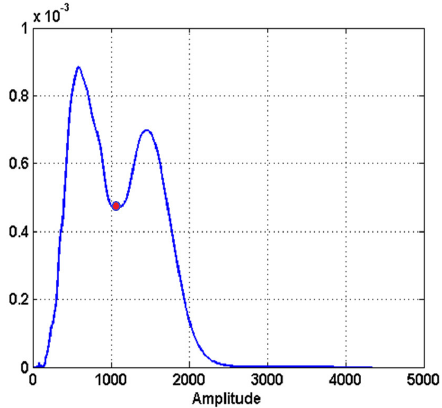
Figure 5. Bimodal distribution.